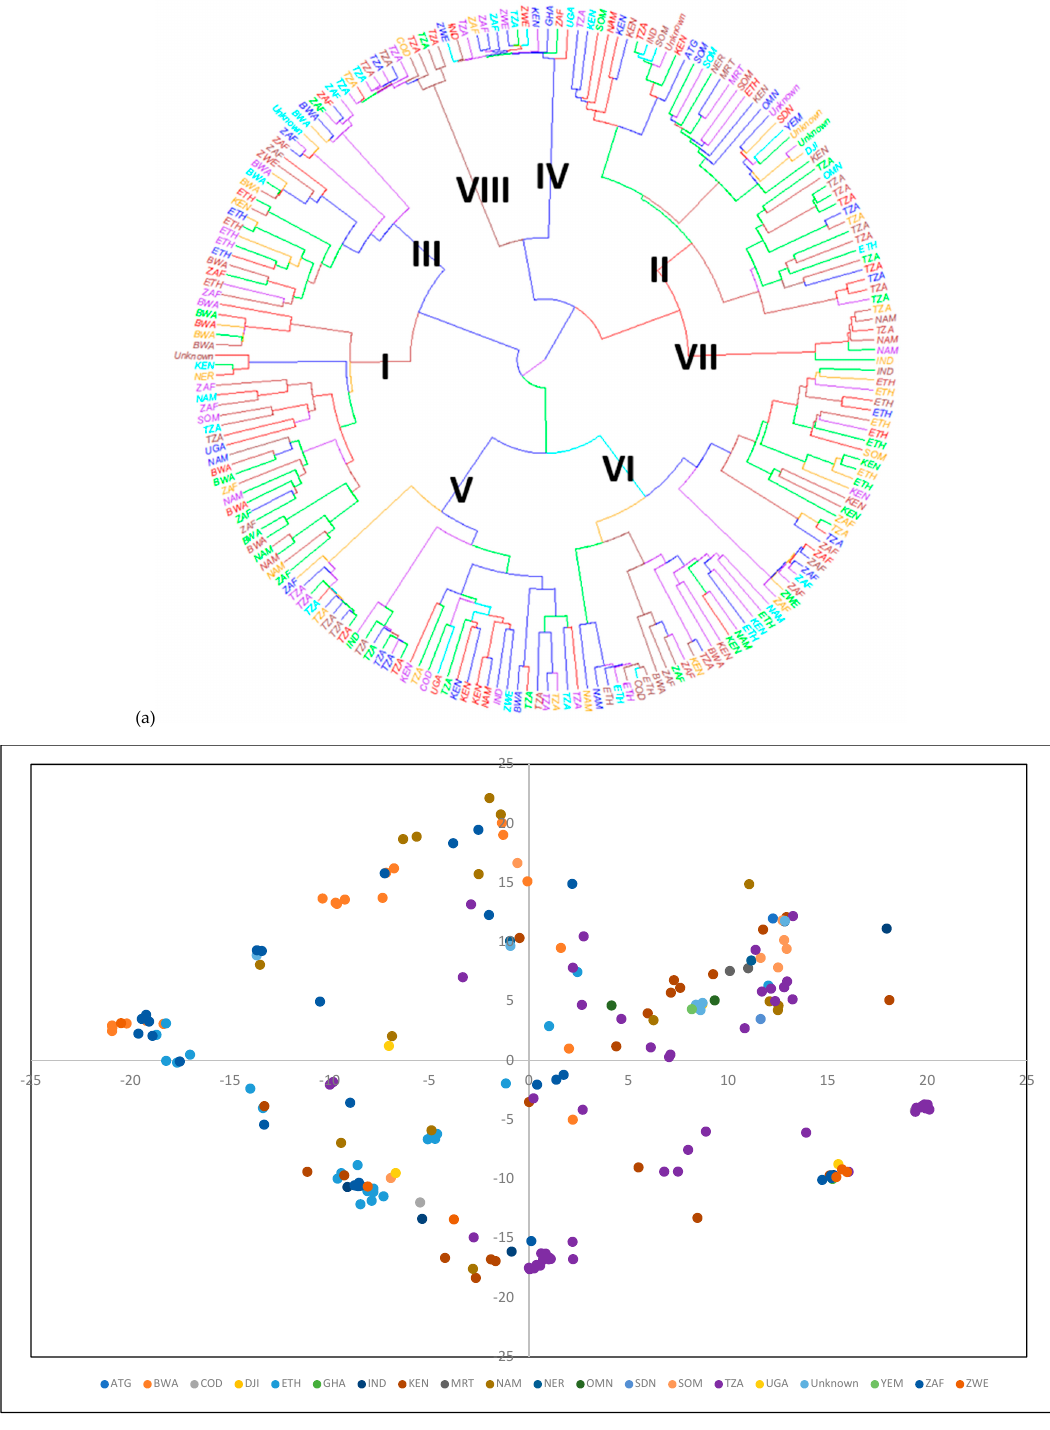
Figure 7. Phylogenetic tree ( a ) and PCA ( b ) showing the geographical origin of the collection. ATG: Antigua and Barbuda, BWA: Botswana, COD: Democratic Republic of the Congo, DJI: Djibouti, ETH: Ethiopia, GHA: Ghana, IND: India, KEN: Kenya, MRT: Mauritania, NAM: Namibia, NER: Niger, OMN: Oman, SDN: Sudan, SOM: Somalia, TZA: Tanzania, UGA: Uganda, YEM: Yemen, ZAF: Republic of South Africa, and ZWE: Zimbabwe.